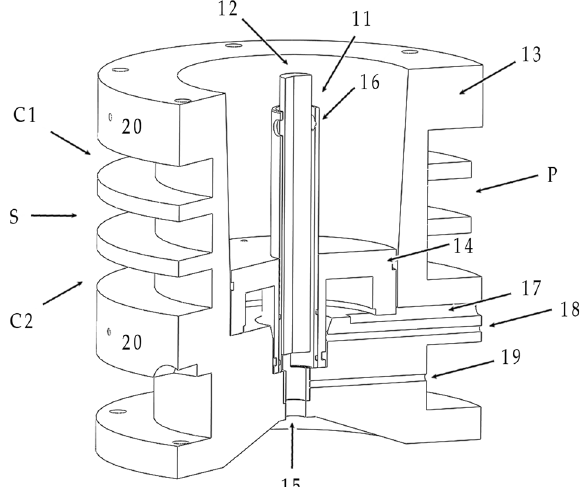
Fig. 1 Quantum Kinetic Fusor design. Coil (C1) and (C2) are respectively Helmholtz coils. Secondary step-up coil (S) laid in conjunction with Primary (P) coil determines resonant voltage to cell. Increasing (S) turn count in reference to (P) turn count increases voltage levels. Transformer tape can be positioned between coils creating an electrical stopgap. (S) and (P) coils positioned between (C1) and (C2) establish a classical Maxwellian Coil arrangement. Modular device can be arranged in series or parallel con fi guration. Electron Extraction is established between electrodes (20), (12) and (11) respectfully. Transparent acrylic lens (14) allows 660 nm (deep red) photon excitation from LEDs to be passed into resonant cavity and stimulates liberated gaseous matter ions in their quantum orbiting electron jumps (K, L and M shells). (17), (18) and (19) are terminal connections for electrodes and LED photon cluster array. Modular design can be stacked in series or parallel arrangement. Polarized dielectric mediums fl ow direction is from 15 (enter) to (exit) 16 respectively during operations.